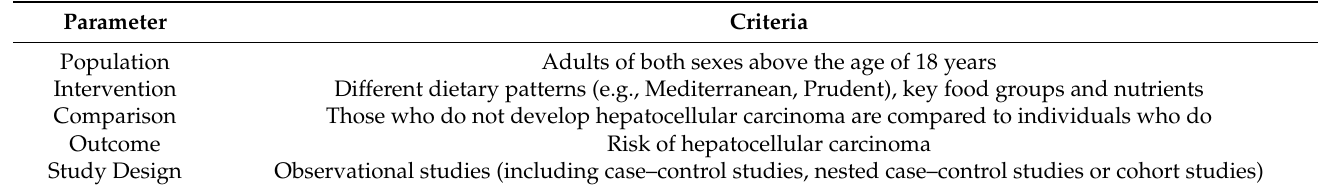
Table 1. PICOS criteria for inclusion and exclusion of